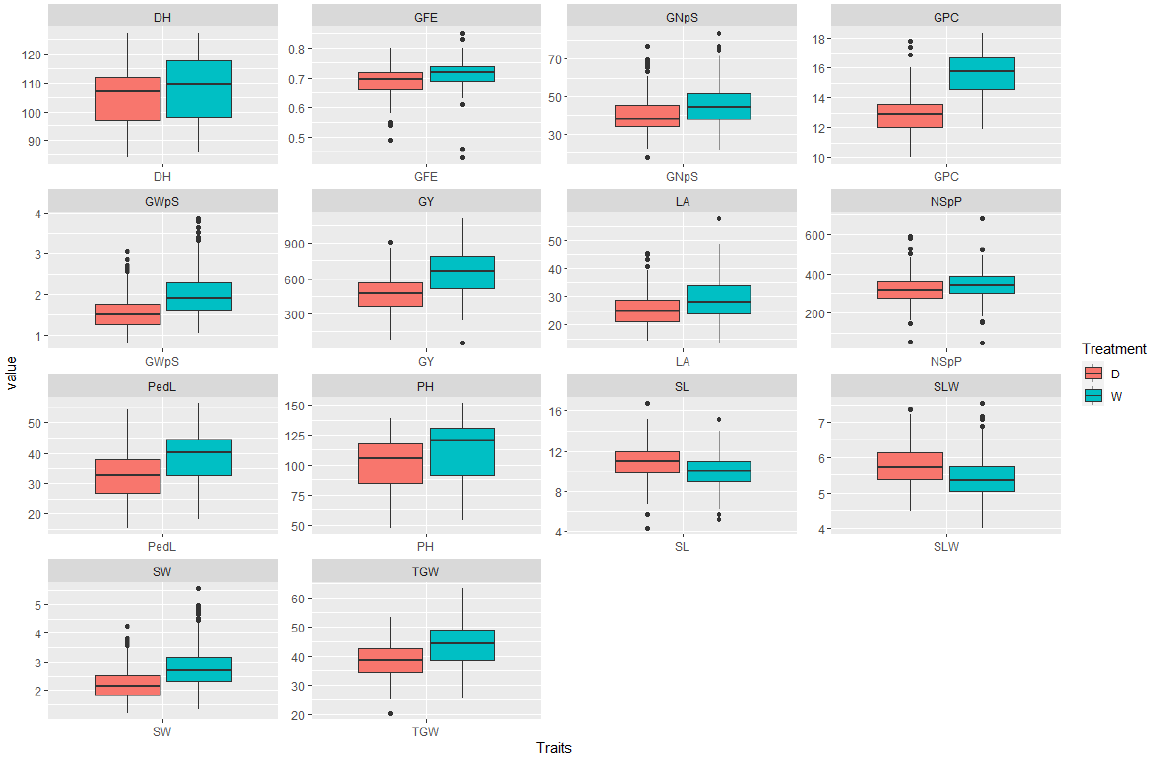
Figure 1. Comparison of averages of phenotypic traits in the wheat panel of 232 accessions, measured under well-watered (W) and water-limited (D) conditions. Key of traits and scales measured units: grain yield (GY, g/m 2 ), grain protein content (GPC, %), spike weight (SW, g), grain weight per spike (GWpS, g), grain number per spike (GNpS, #), number of spikes per plot (NSpP, #), thousand-grain weight (TGW, g), the efficiency of grain filling (GFE, #), leaf area (LA, cm 2 ), specific leaf weight (SLW, mg/cm 2 ), plant height including spike (PH, cm), peduncle length (PedL, cm), spike length (SL, cm), days-to-heading (DH, #).